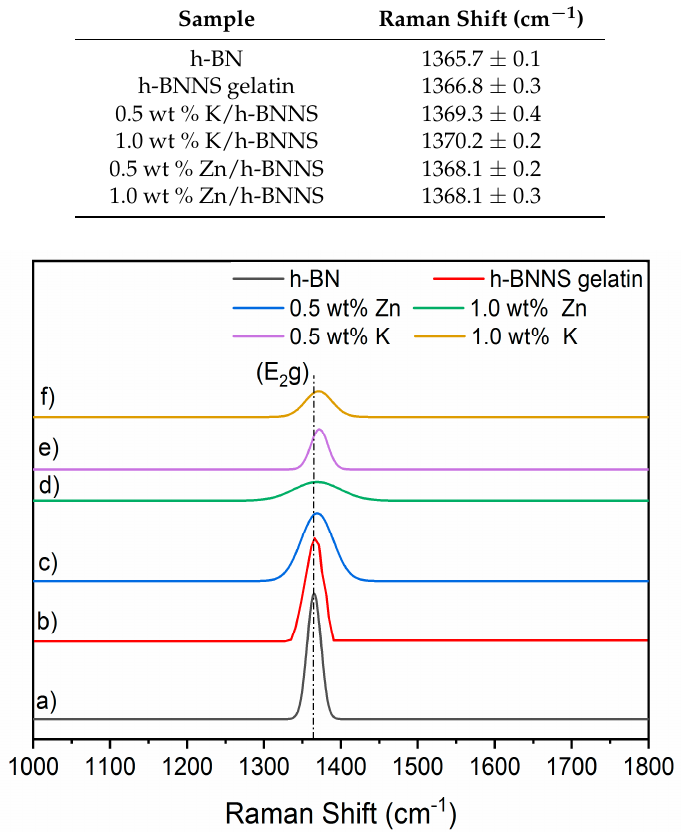
Table 4. Raman shift of h-BN, h-BN gelatin and h-BNNS intercalated with different concentrations of KCl and ZnCl 2 .